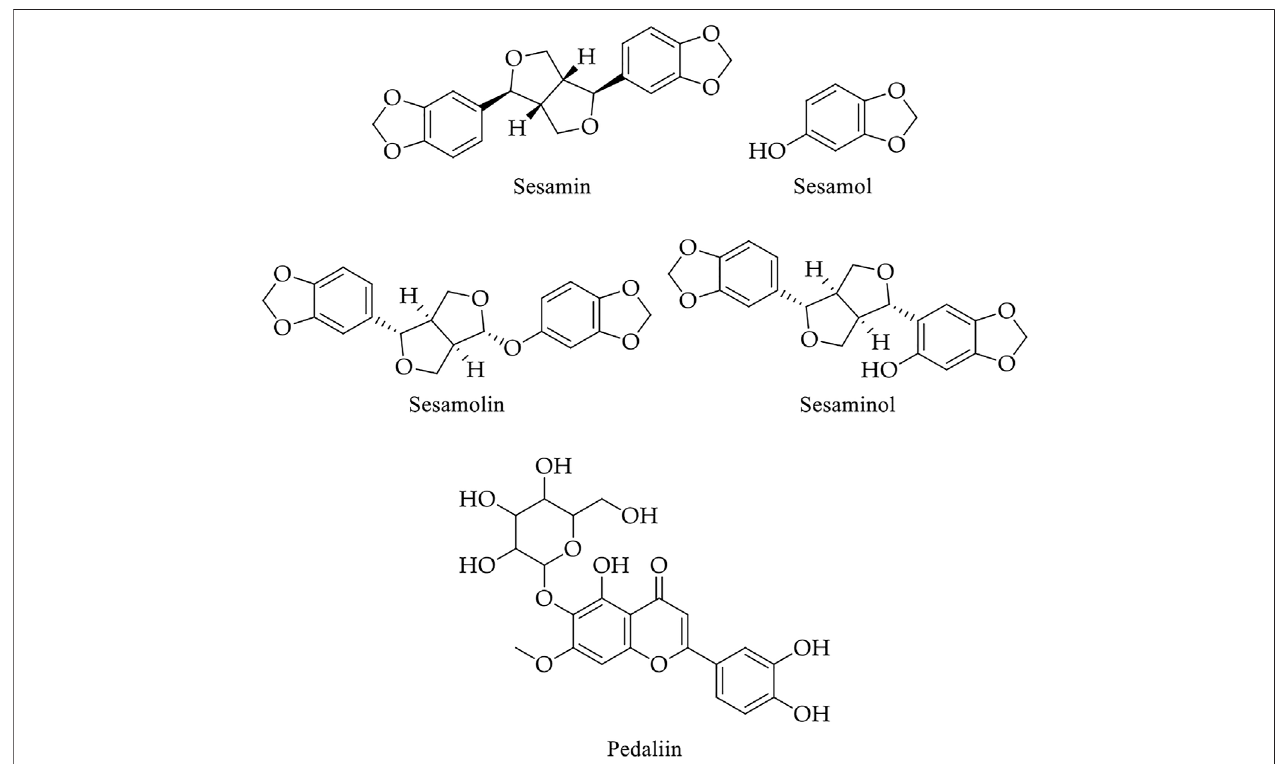
FIGURE 12 | Chemical structure of main bioactive compounds of sesame.